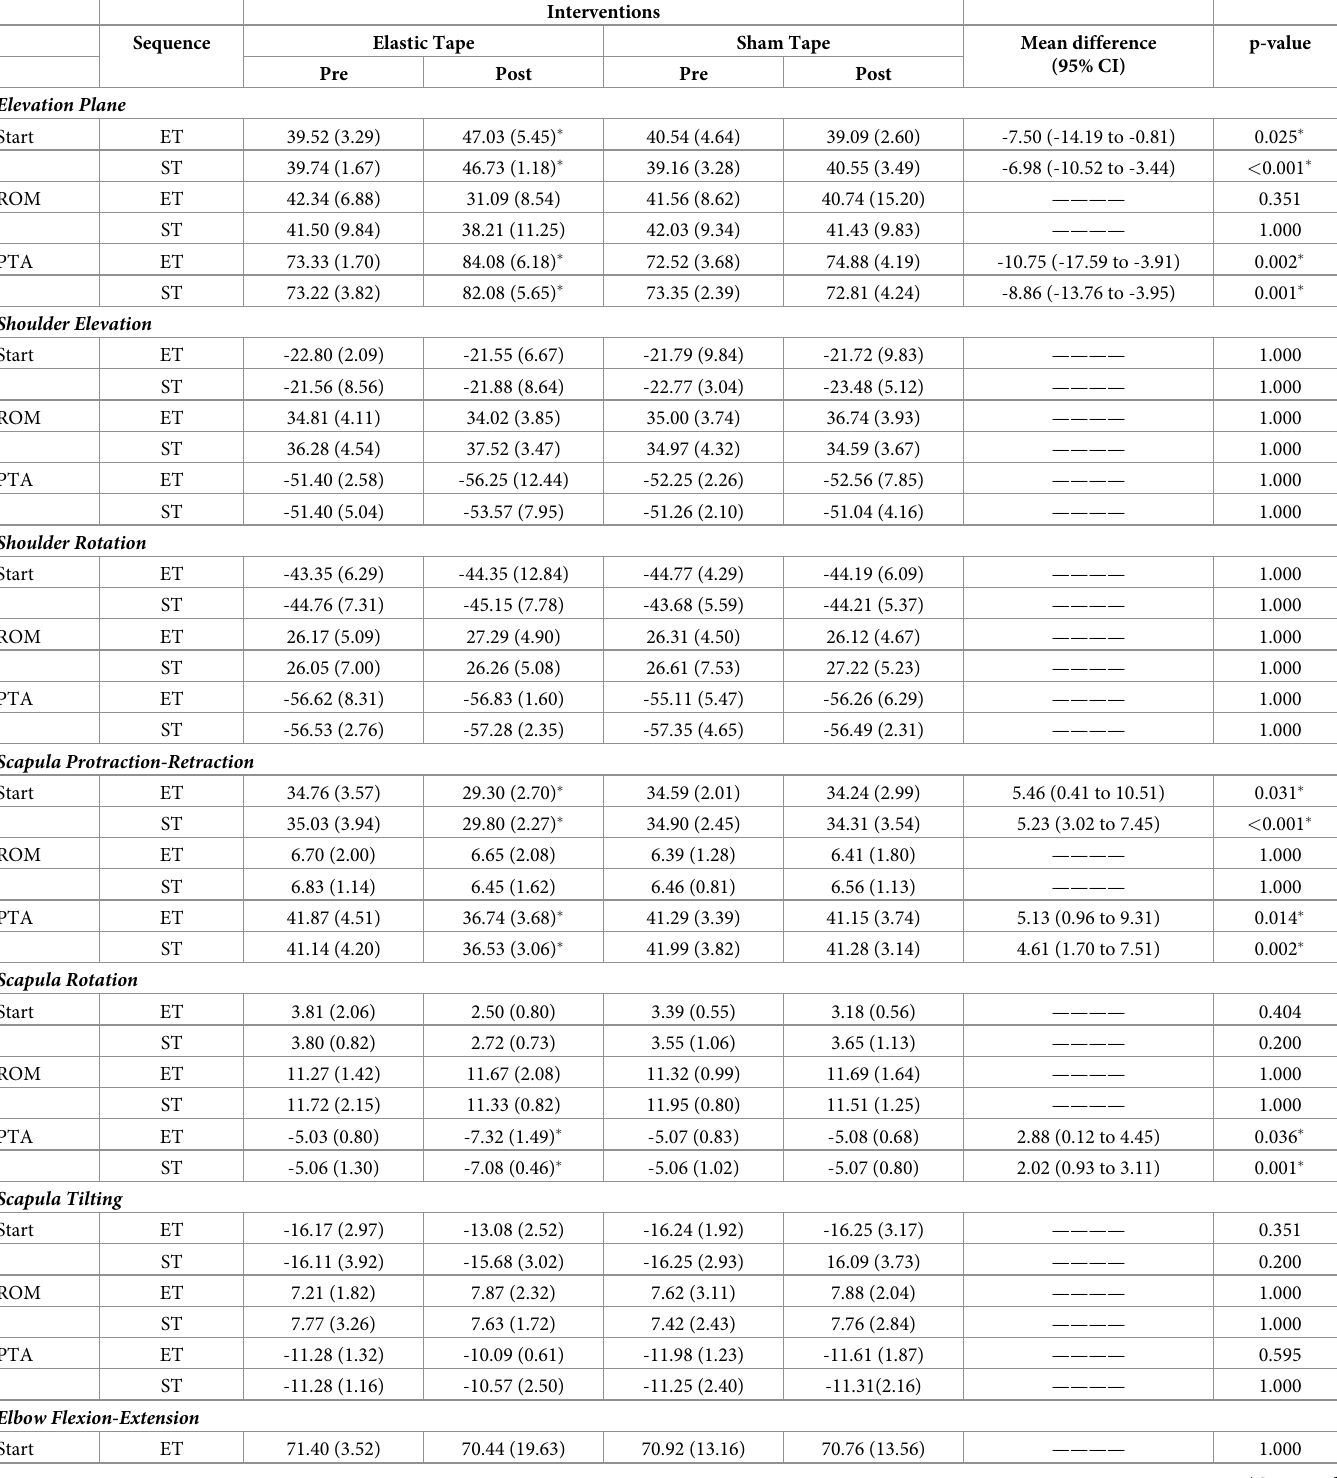
Table 1. ROM, starting angles, and PTA for all joints assessed while reaching for a glass for both sequences (groups: ET and ST) pre and post-interventions (elastic and sham tape).